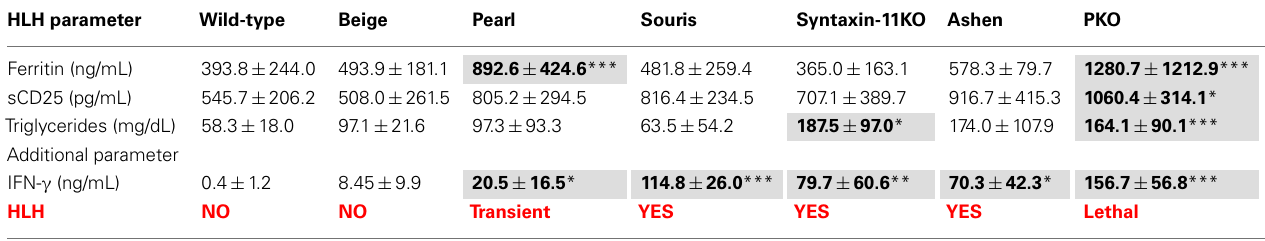
TableA1 |Analysis of HLH biomarker on day 8 after LCMV infection